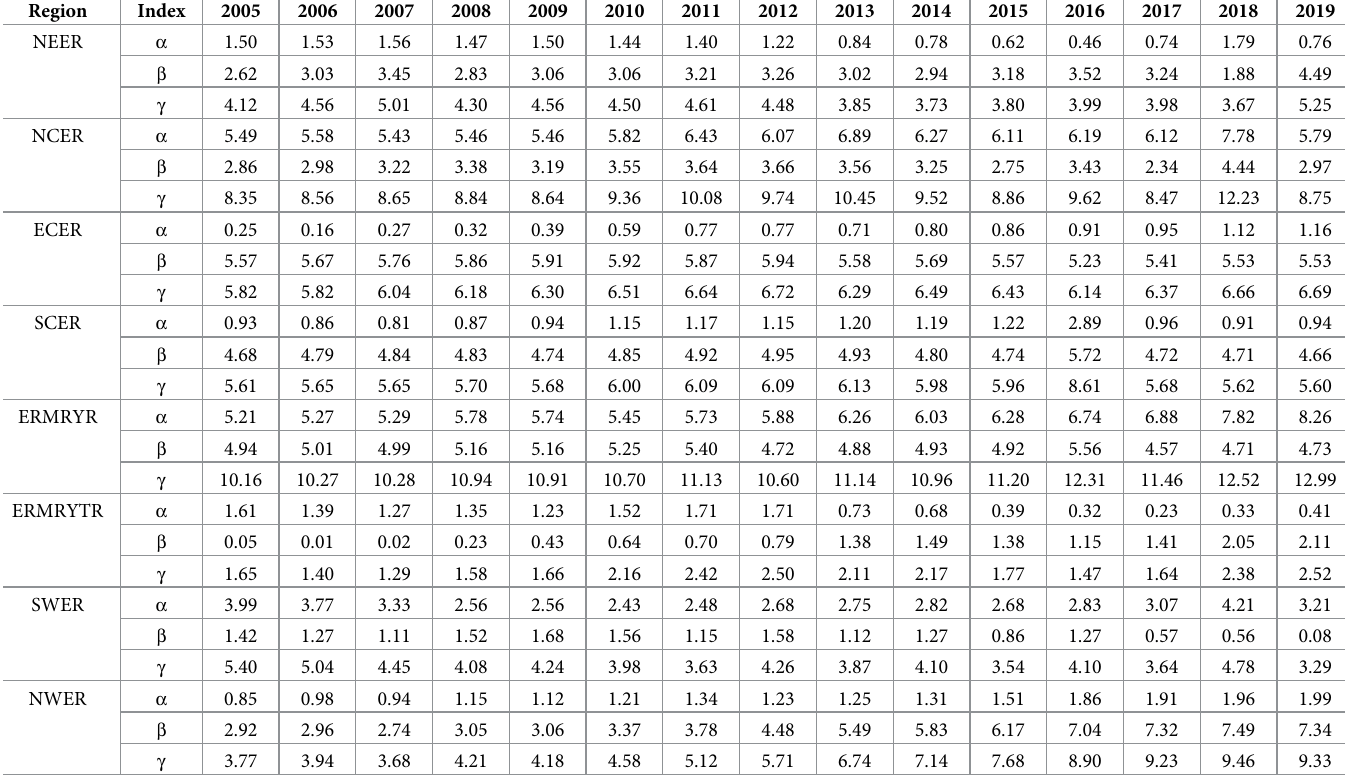
Table 3. Theil index of regional carbon emission difference and its decomposition results.